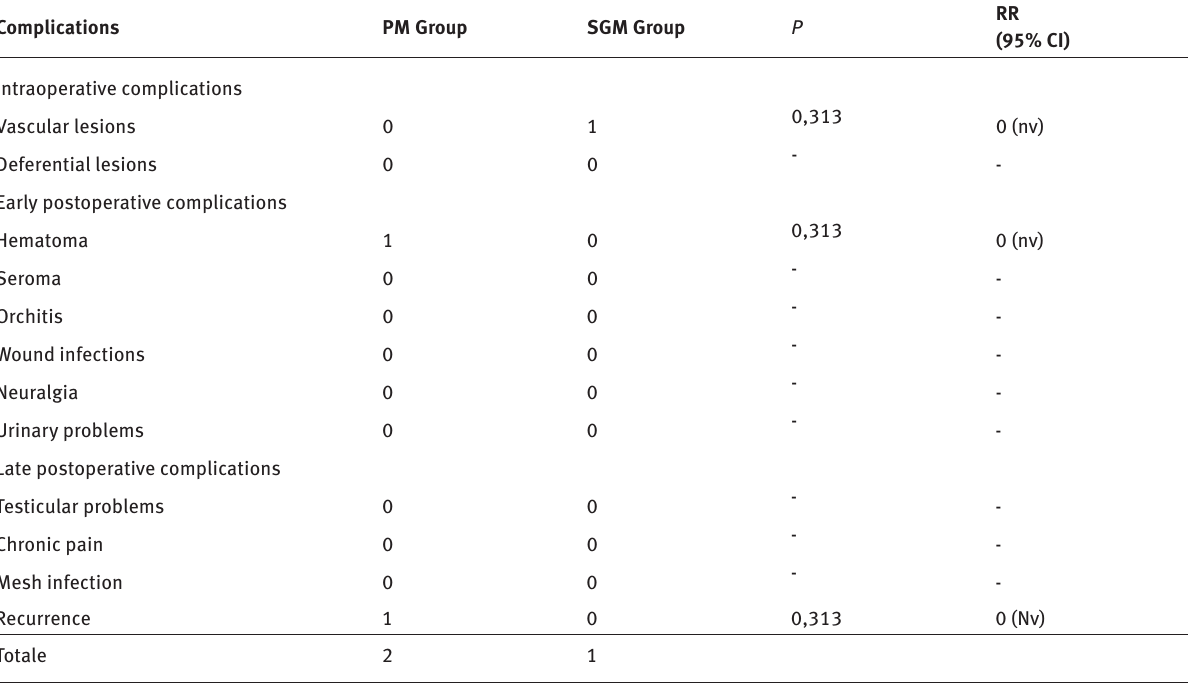
Table 3: Complications